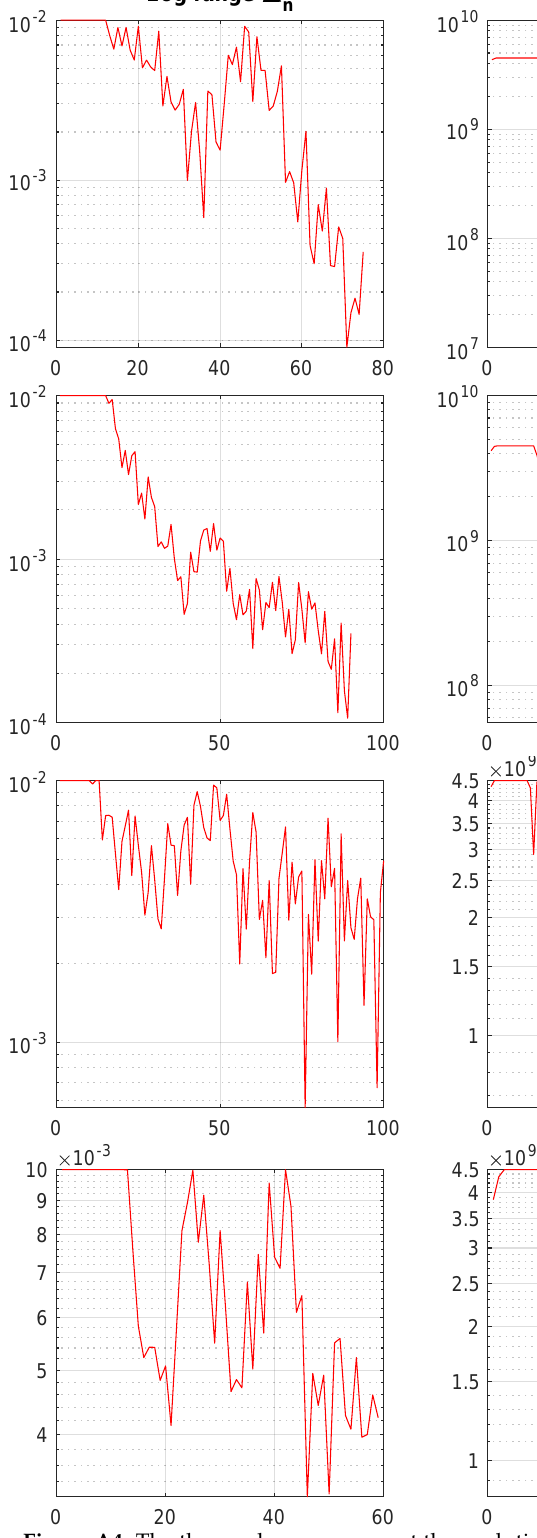
Figure A4. The three columns represent the evolution of each optimization variable ranges, respectively: ∆ n , µ and G The horizontal axes are the PSO iterations and the vertical axes are in the units of the corresponding variable, Pa or adimentional for δ n . Swarm Population: 40. Objective function f ( x ) resolution from top to bottom: 8–16–24–32